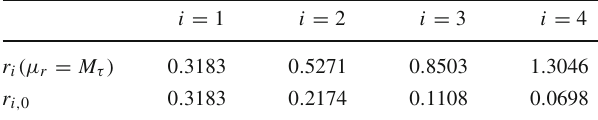
Table 4 The predicted smallest 95 . 5% credible intervals (CI) for the scale-dependent conventional coefficients r i (μ r ) ( i = 3 , 4 , 5) at the scale μ r = M τ and the scale-invariant coefficients r i , 0 ( i = 3 , 4 , 5 ) of ˜ R ( M τ ) via the Bayesian-based approach. The exact values (“EC”) n